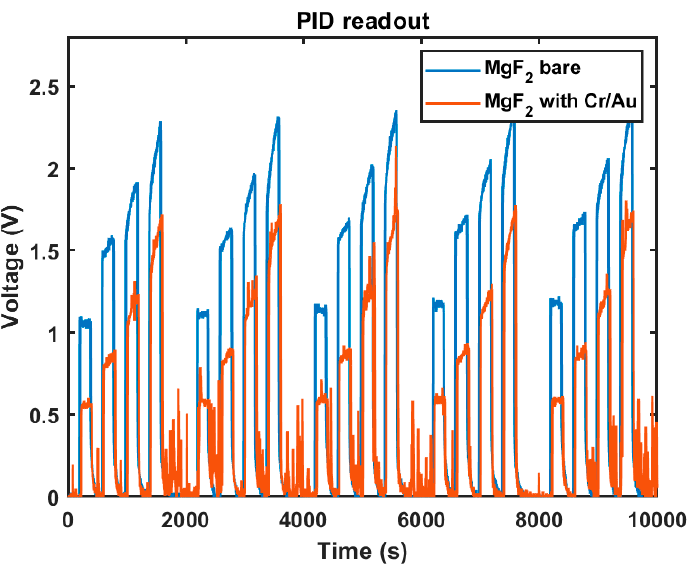
Figure 3. PID sensor readout with Cr/Au nanolayer stack (orange line) and using a bare MgF 2 window (blue line).